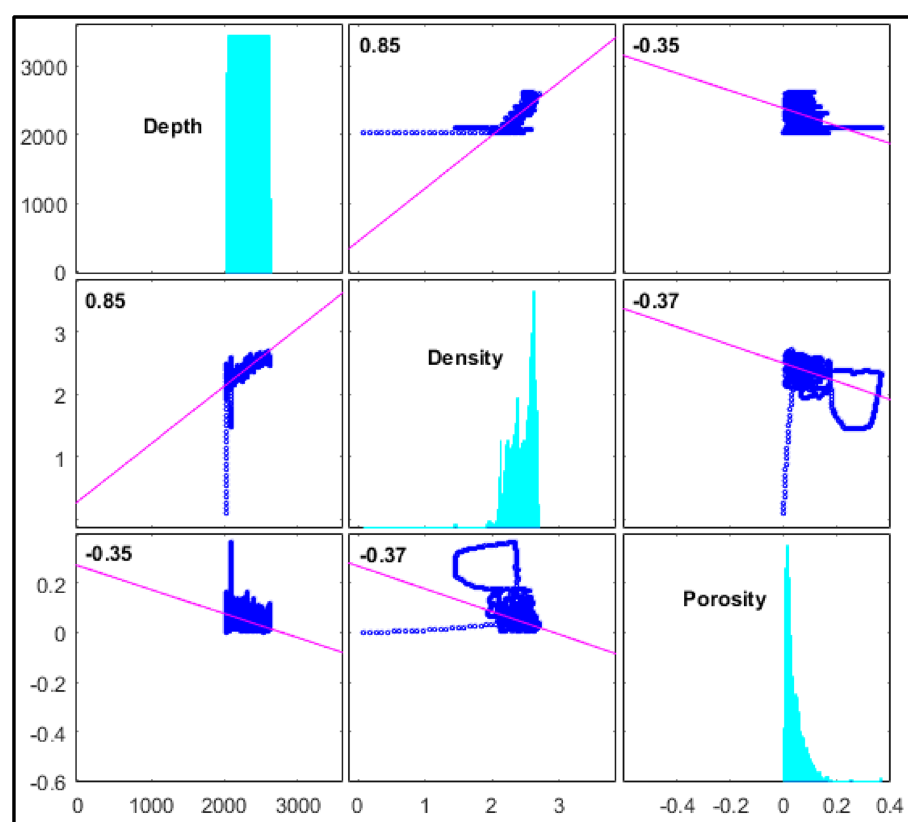
Fig. 9 Correlation matrix of well-2 among depth, density, and porosity with diagonal histogram and correlation coef-